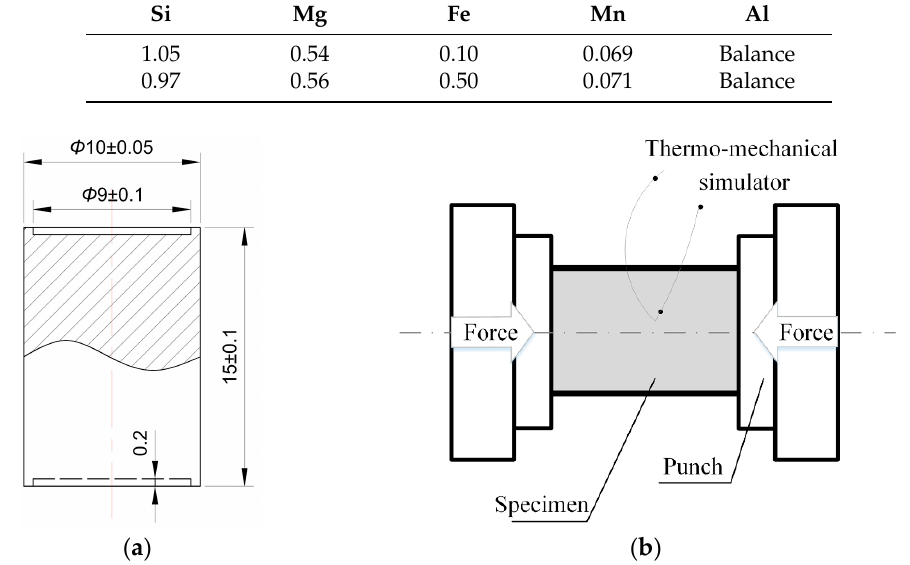
Figure 1. ( a ) Geometries of the cylindrical specimen for hot compression tests (units in mm) and ( b ) illustration of hot compression in the MMS300 thermo-mechanical simulator.